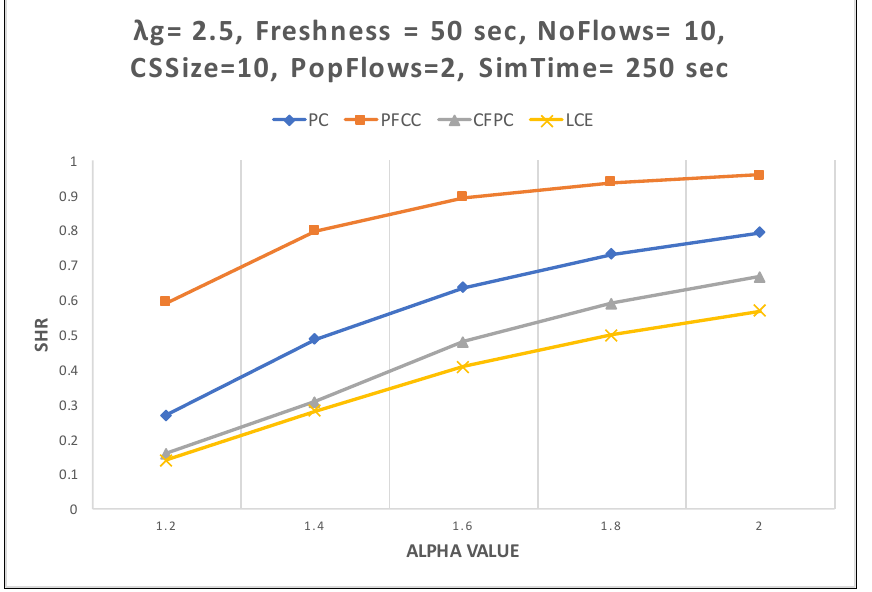
Figure 12. Server hit reduction ratio for popular traffic as a function of popularity rate.